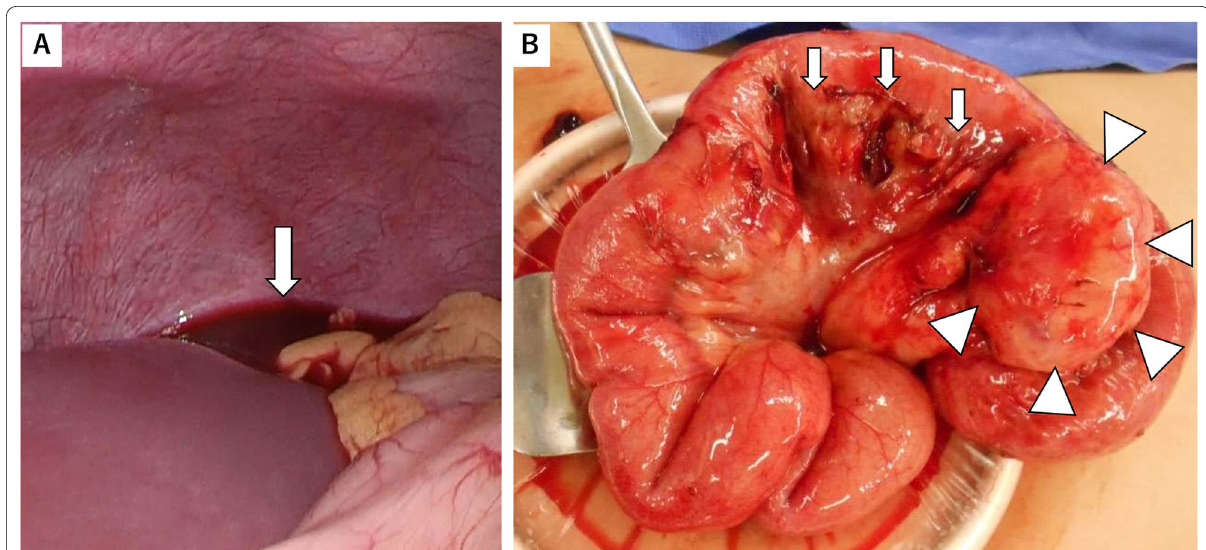
Fig. 2 Intraabdominal findings. A Laparoscopic observation revealed a total of 200 ml of fresh blood throughout the peritoneal cavity, spreading to the subphrenic spaces (arrow). B Operative findings. Meckel’s diverticulum (arrow heads) was observed, with bleeding from surrounding mesentery